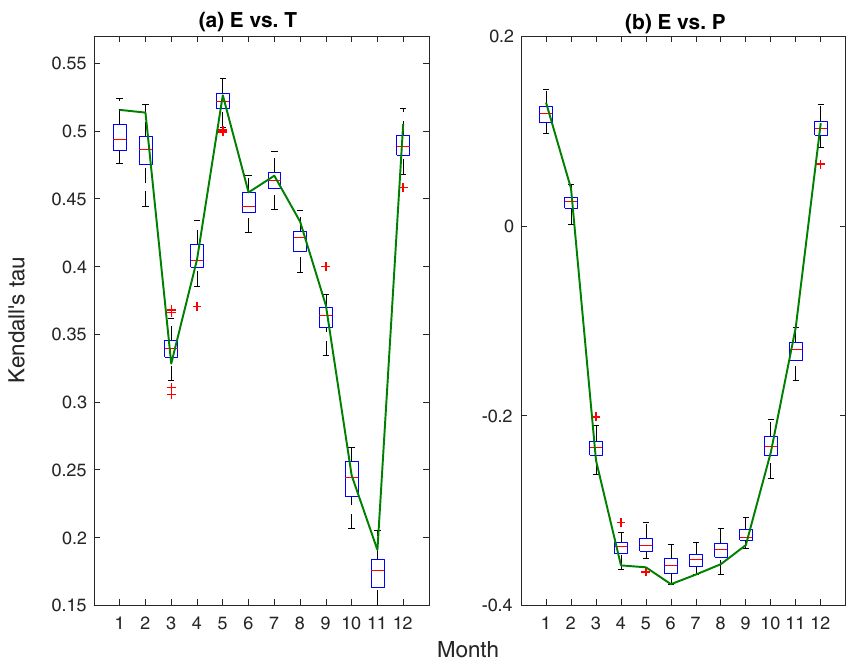
Figure 5. Comparison between Kendall’s tau for the relations of E vs. T (a) and E vs. P (b) of observed and simulated values: Uccle is shown by the green line and the 50 simulated time series are shown by box